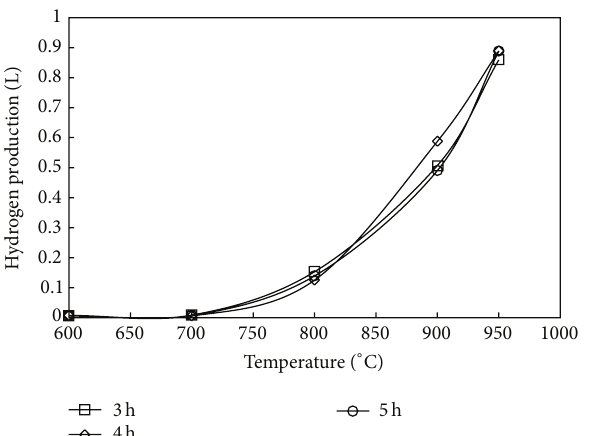
Figure 10: The catalytic activity of different silver calcination times.